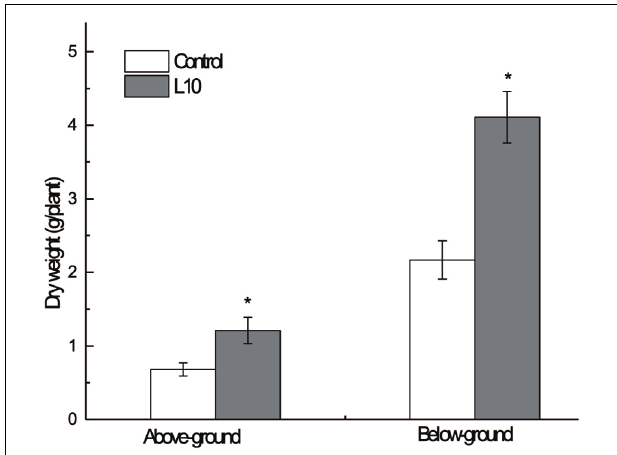
FIGURE 4 | Effect of endophytic isolate L10 on the growth of the Phragmites australis . Bars indicate standard deviation ( n = 6). Dried mass of inoculated plants was significantly greater (Student’s t -test; P < 0.05).